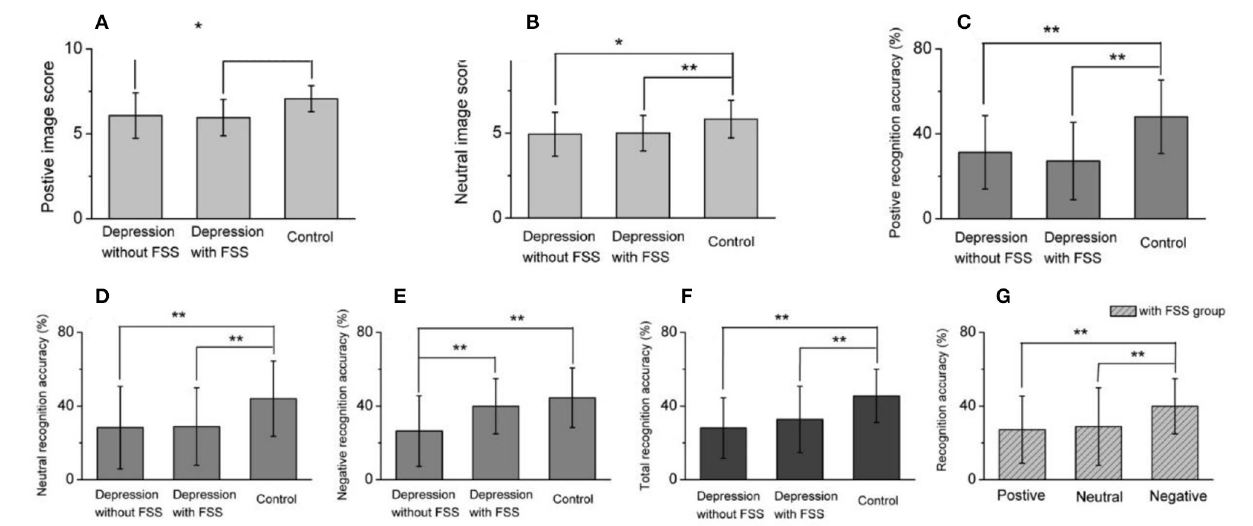
FIGURE 2 | Comparison for image score or recognition accuracy between three groups and different image recognition accuracy within FSS group. (A,B) Summarized data for positive (A) and neutral (B) image score recognition accuracy, showing that both positive and neutral image score in depression with or without FSS were significantly lower than healthy control. (C–E) Comparative analysis for the averaged data of positive, neutral and negative image recognition accuracy, suggesting that the recognition accuracy of positive and neutral images in depression with FSS or without FSS was significantly lower than that of healthy control (C,D) , but in negative image recognition accuracy, depression without FSS was significantly lower than with FSS, synchronously lower than healthy control (E) . (F) Summarized data for the total recognition accuracy in three groups. (G) Within depression with FSS group, negative image recognition accuracy was significantly higher than positive or neutral image, respectively. * p < 0.05, ** p <